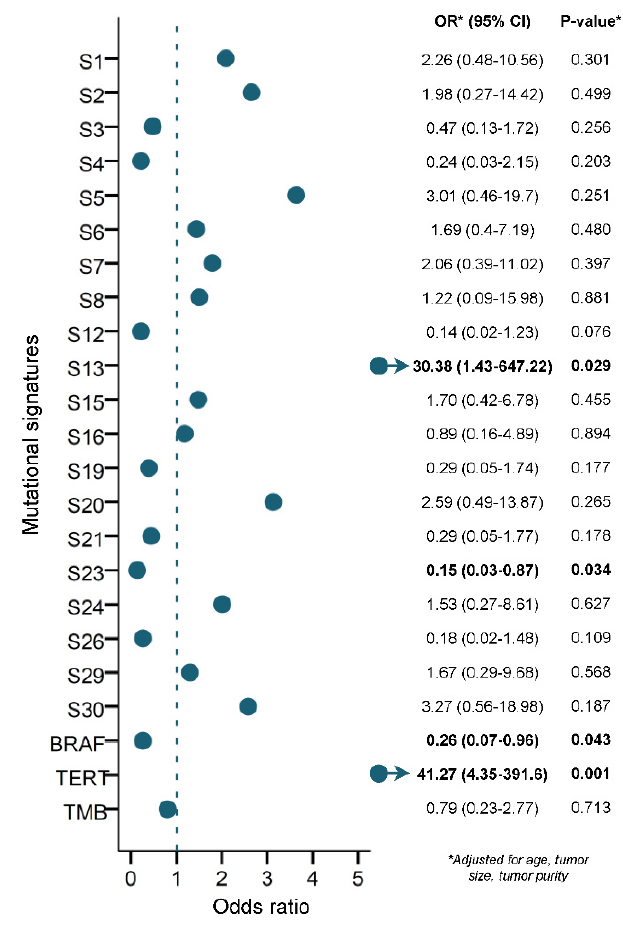
Figure 3. Multivariable logistic regression model (when adjusting for age, tumor size and tumor purity as continuous variables), using mutational signatures, BRAF V600E mutation, TERT promoter mutation and TMB to predict RAI refractoriness in PTC. An alpha level of 0.05 was used for statistical significance. S1 represents age-related mutations; S2 and S13 represent APOBEC-related mutagenesis; S6, S15, S20, S21 and S26 represent defective DNA mismatch-repair (MMR) mutations; S3 represents defective homologous recombination-related DNA repair (HR); S30 represents defective base-nucleotide excision repair (BER); S4 represents tobacco smoking; S7 represents ultraviolet (UV) exposure; S24 represents aflatoxin exposure; S29 represents chewing tobacco; and S5, S8, S12, S16, S19 and S23 are of unknown etiology.